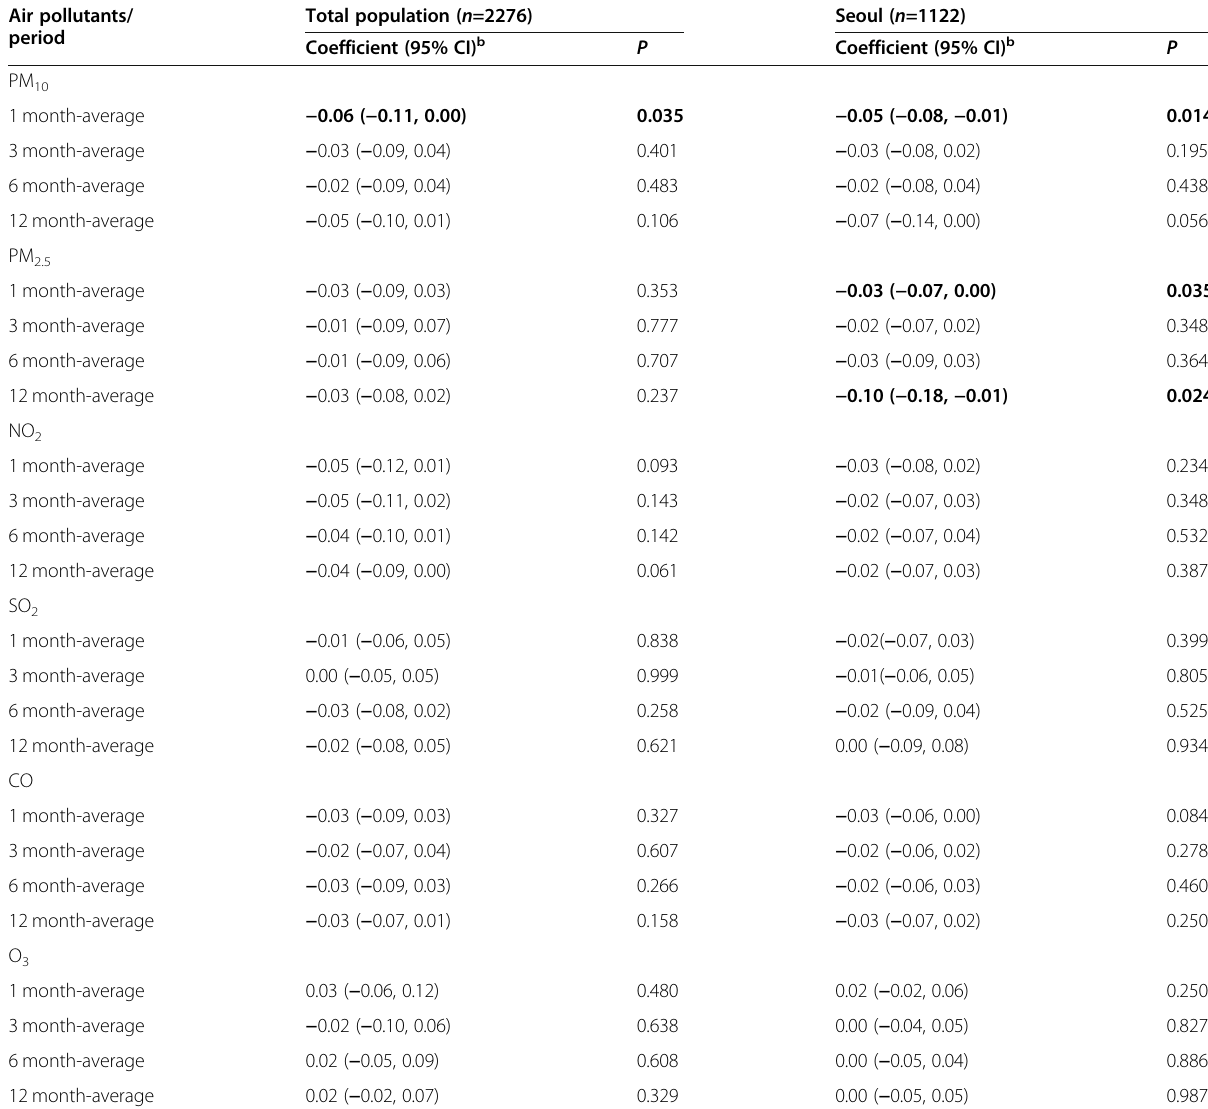
Table 2 Change in AMH ratio a per interquartile range (IQR)-increase in six air pollutant concentrations among total population ( n = 2276) and Seoul residents ( n